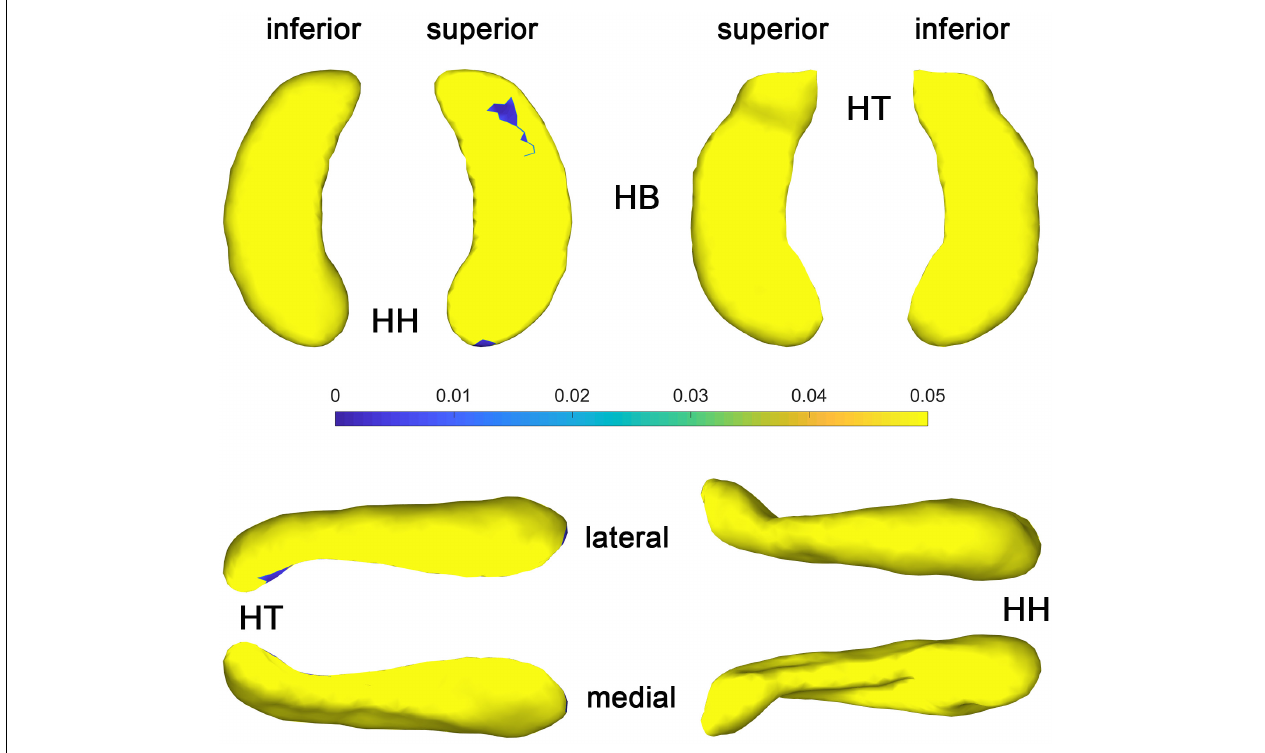
FIGURE 6 | P value maps of late blind subjects compared with control group after FDR correction, from left to right columns are p value maps of left and right HF, respectively, p < 0.05 was considered as statistically significant. HH, hippocampal head; HB, hippocampal body; HT, hippocampal